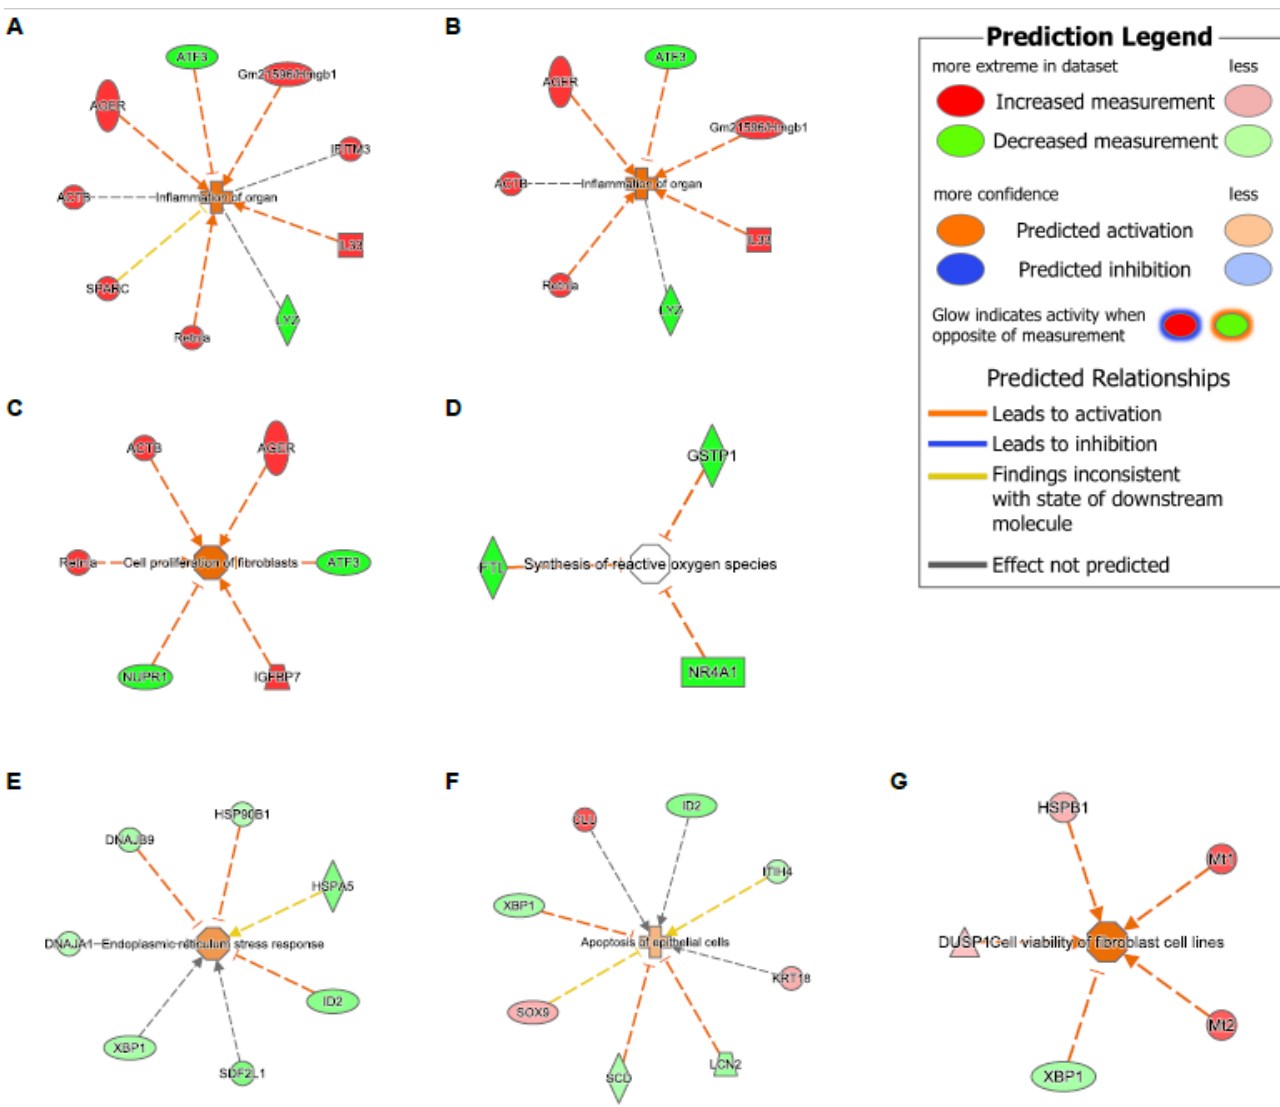
Figure 5. Diseases and function analysis in EpCAM + , AT2, and ciliated cells via IPA. (A-D) DEGs with consistent direction changes among 3 comparisons (WT-HDM vs. WT-Sal, KO-Sal vs. WT-Sal, and KO-HDM vs. WT-Sal). ( A ) Inflammation of organ in EpCAM + cells (z = 1.866, overlapping p = 7.54 × 10 − 4 ). ( B ) Inflammation of organ in AT2 cells (z = 2.097, p = 2.93 × 10 − 3 ). ( C ) Cell viability of fibroblast in AT2 cells (z = 2.408, p = 3.51 × 10 − 6 ). ( D ) Synthesis of reactive oxygen species in ciliated cells ( p = 3.54 × 10 − 4 ). ( E ) Endoplasmic reticulum stress response (z = 1.015, p = 6.74 × 10 − 6 ), ( F ) apoptosis of epithelial cells (z = 0.651, p = 6.85 × 10 − 5 ), and ( G ) cell viability of fibroblast cell lines (z = 2.236, p = 1.41 × 10 − 4 ) in DEGs in KO-HDM vs. WT-HDM in AT2 cells.